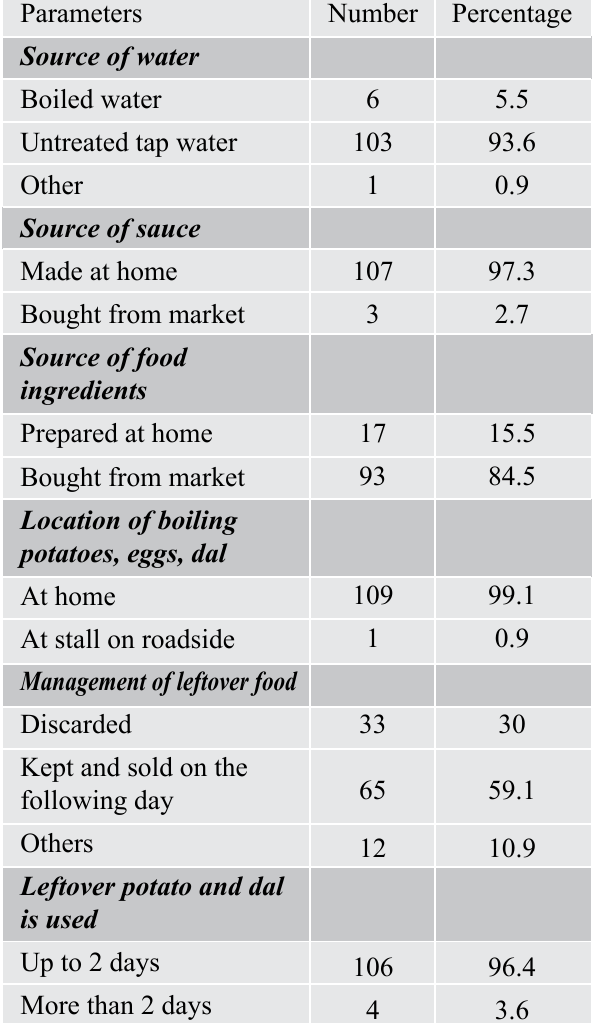
Table III: Source of ingredients, preparation and management of leftover food (N=110)